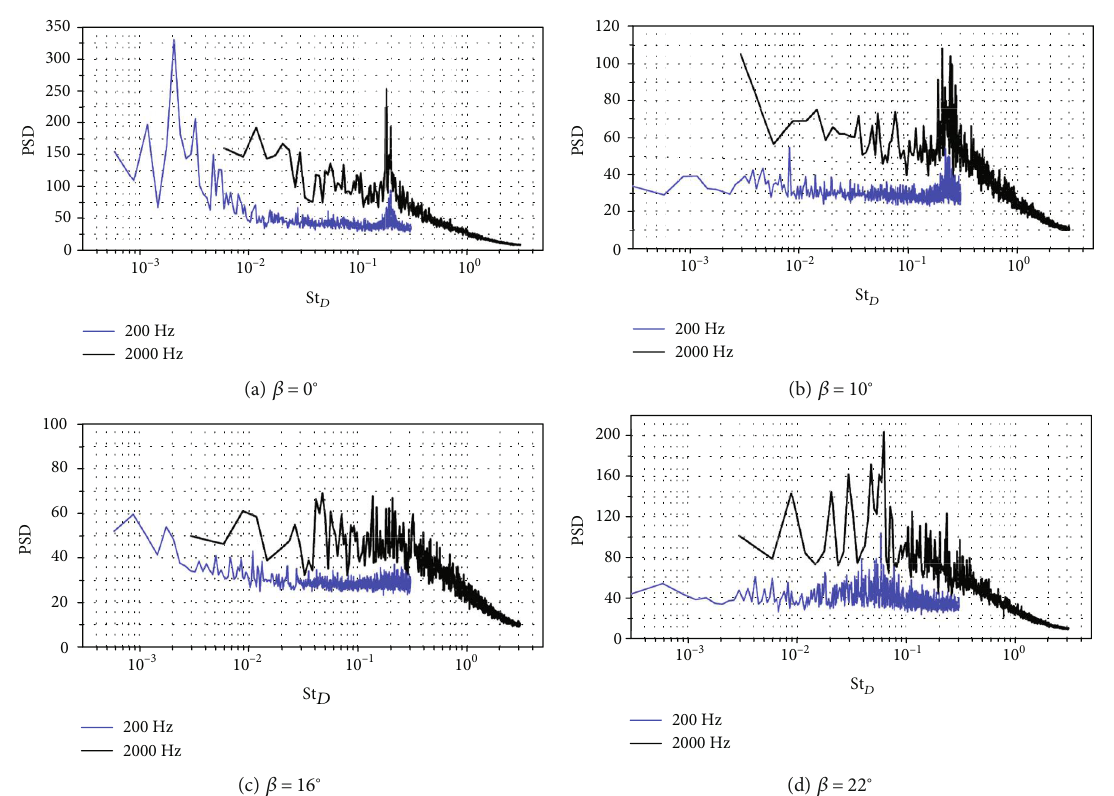
Figure 14: Global power-spectral density of wake fl ow (a) β = 0 ° , (b) β = 10 ° , (c) β = 16 ° , and (d) β = 22 °